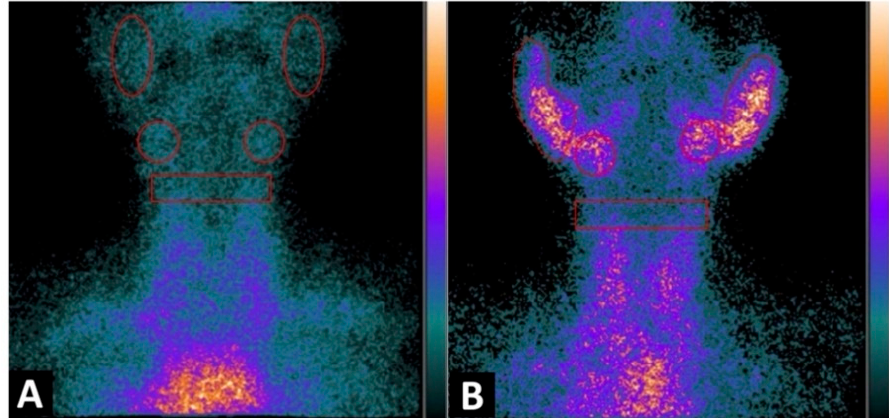
Figure 5. Planar image of the neck was obtained 1h after 99m Tc-IL2 injection in a control subject ( A ) and in a patient with Sjögren syndrome at the time of diagnosis ( B ). In ( A ) the scan shows no 99m Tc-IL2 uptake by the salivary glands. In ( B ) an evident accumulation of 99m Tc-IL2 can be observed in both parotids and submandibular glands, indicating the presence of activated lymphocytes. The calculated parotid to background (P/B) ratios are 1.35 and 1.30 in right and left glands, respectively, and the submandibular gland to background (S/B) ratios are 1.57 and 1.64 in right and left glands, respectively. Reprinted with permission from Imaging Activated-T-Lymphocytes in the Salivary Glands of Patients with Sjögren’s Syndrome by 99mTc-Interleukin-2: Diagnostic and Therapeutic Implications Campagna, G.; Anzola, L. K.; Varani, M.; Lauri, C.; Gentiloni Silveri, G.; Chiurchioni, L.; et al. J. Clin. Med. 2022 , 11 (15), 4368.